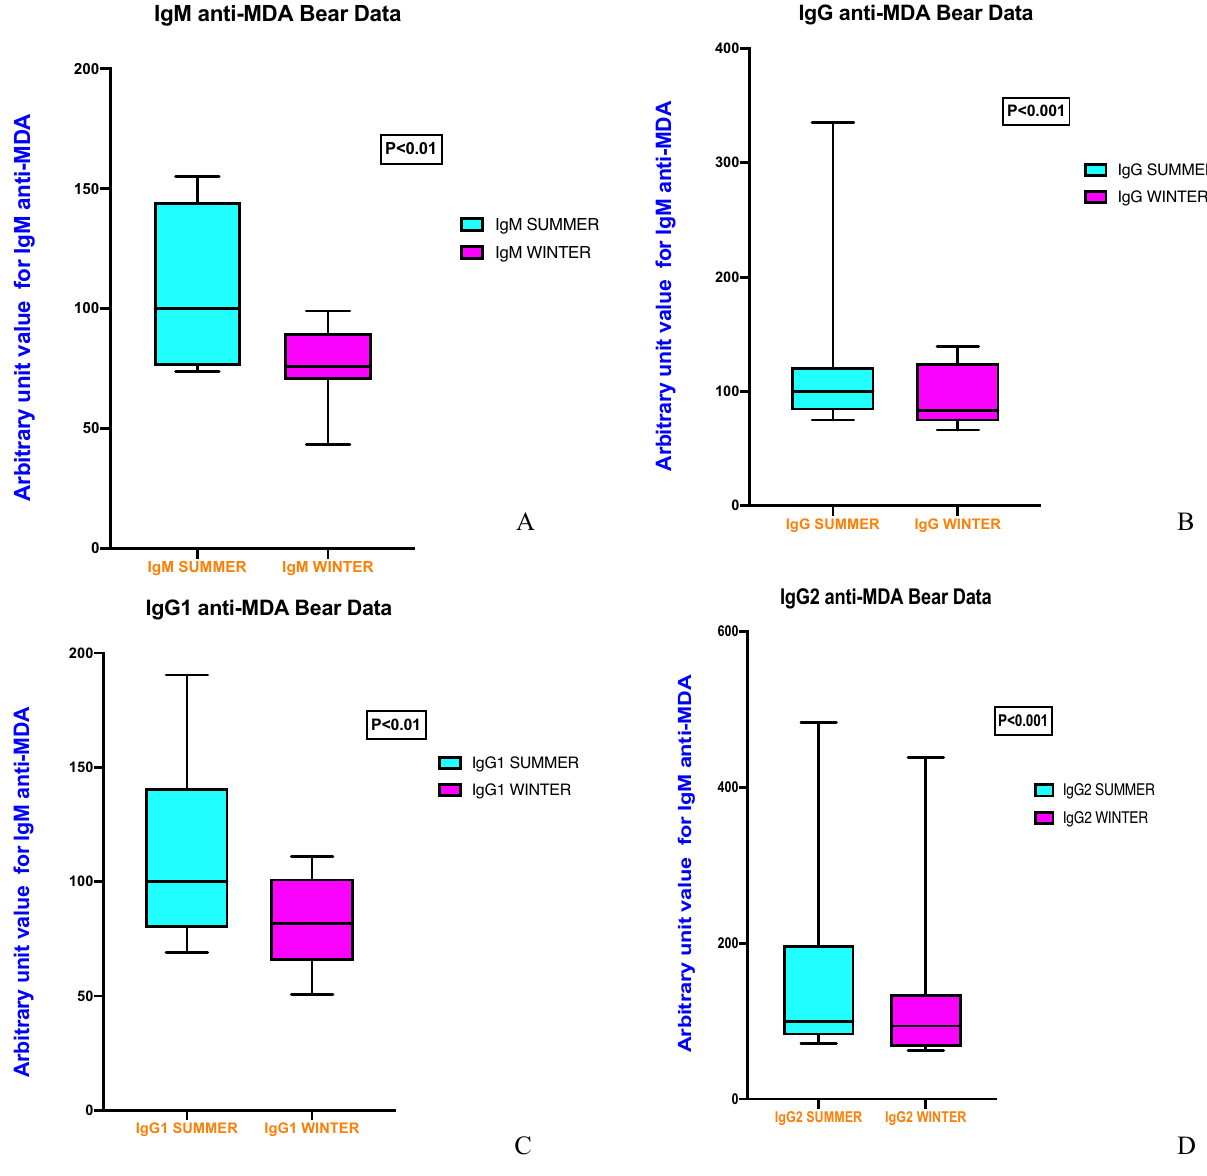
Figure 2. ( A ) IgM anti-MDA levels during summer and winter (p < 0.01), ( B ) IgG anti-MDA levels during summer and winter (p < 0.001), ( C ) IgG1 anti-MDA levels during summer and winter (p < 0.01), ( D ) IgG2 anti-MDA levels during summer and winter (p < 0.001). Samples were tested using Student’s paired T test when normally distributed, as determined by Skewness and Kurtosis. if not normally distributed, values were compared using Wilcoxon signed rank test by using GraphPad Prism version 9.0.0 for Mac OS X, GraphPad Software, San Diego, California USA, www. graph pad.